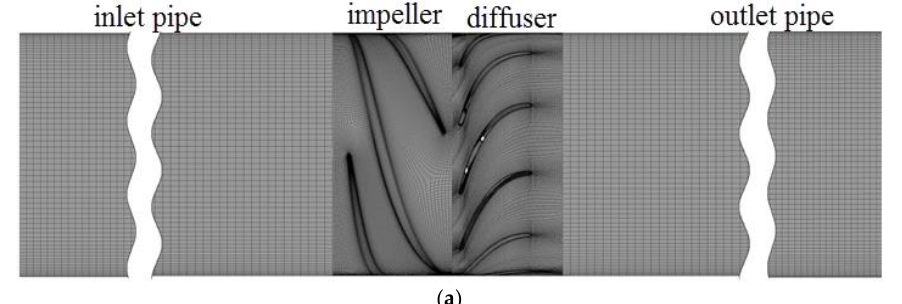
Table 2. Information on expressions of the gas-liquid interphase forces.